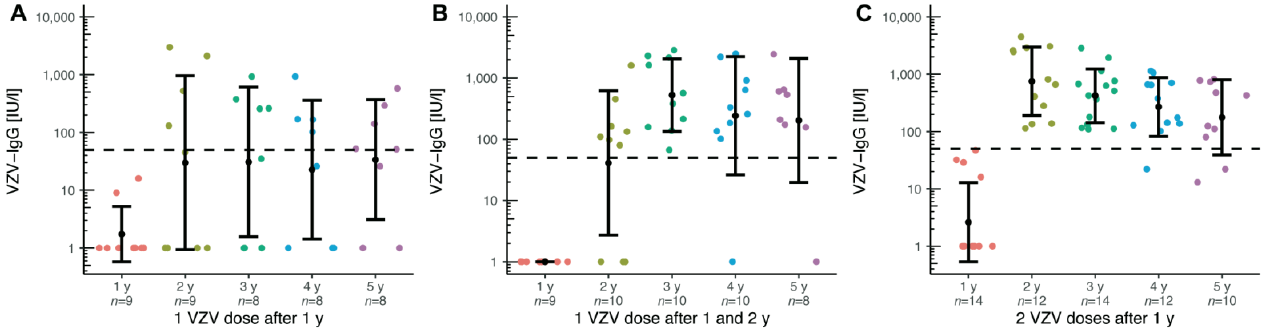
Figure 1. ( A ) VZV-specific antibodies before and 1 year after paediatric liver transplantation, depending on number of VZV vaccinations prior to transplantation. The y -axis is scaled logarithmically. Data is shown as mean ± standard deviation. The dashed line marks the threshold for serological protection. All groups show a decrease in mean titre after transplantation, regardless of the number of vaccine doses. However, as the bar plots in ( B ) show, patients with protective VZV antibodies after 1 vaccination are more than 60%, and after 2 vaccinations, more than 85% are still serologically protected. Significant data is marked as follows: * <0.05, ** <0.01, *** <0.001.